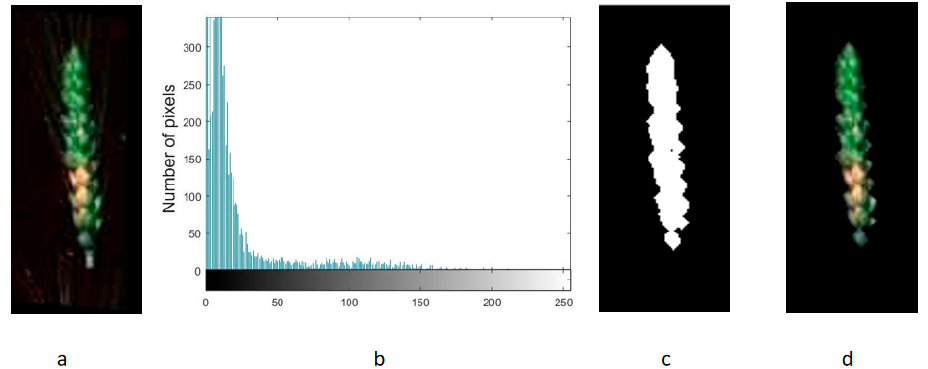
Figure 3. Segmentation of wheat ear. ( a ) The wheat RGB image of infected FHB; ( b ) The gray histogram of the image; ( c ) The binary map of the wheat ear image with the separation background; ( d ) The wheat RGB image contained only the region of interest.